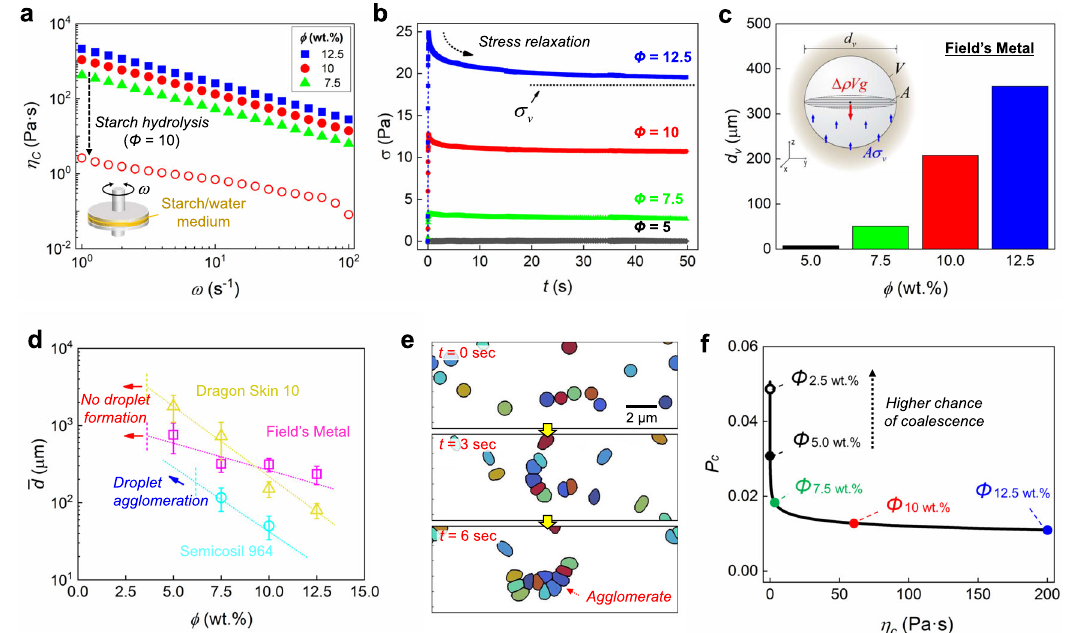
Fig. 3 Characterization of the static-state particle fabrication process. a Rheological behavior of the starch/water medium. Either increasing a starch concentration ϕ in the medium or decreasing a shearing rate ω increases the viscosity of the medium η . Hydrolysis of the starch reduces the viscosity η , C C thereby facilitating the particle cleaning procedure. b Stress relaxation of the starch/water medium. The vitri fi cation stress σ v is de fi ned where the residual stress plateaus after 1 h. c Vitri fi cation diameter d v of Field ’ s Metal (FM) particles in the starch/water medium. Increasing ϕ results in a higher d v attributed to the increased σ . d A relation of the concentration ϕ and the mean particle diameter (cid:1) d for polymer resins and FM. Two types of polymer resins are used: v high-viscosity Dragon Skin 10 and low-viscosity Semicosil 964. Error bars denote one standard deviation. e Time-lapse images of simulated particle collision and coalescence behavior. Each particle is differently color-coded for clarity. f Coalescence probability P c as a function of the viscosity η . Starch C concentration ϕ in correspondence to η reveals that a higher starch concentration in the medium mitigates the coalescence of the distributed C